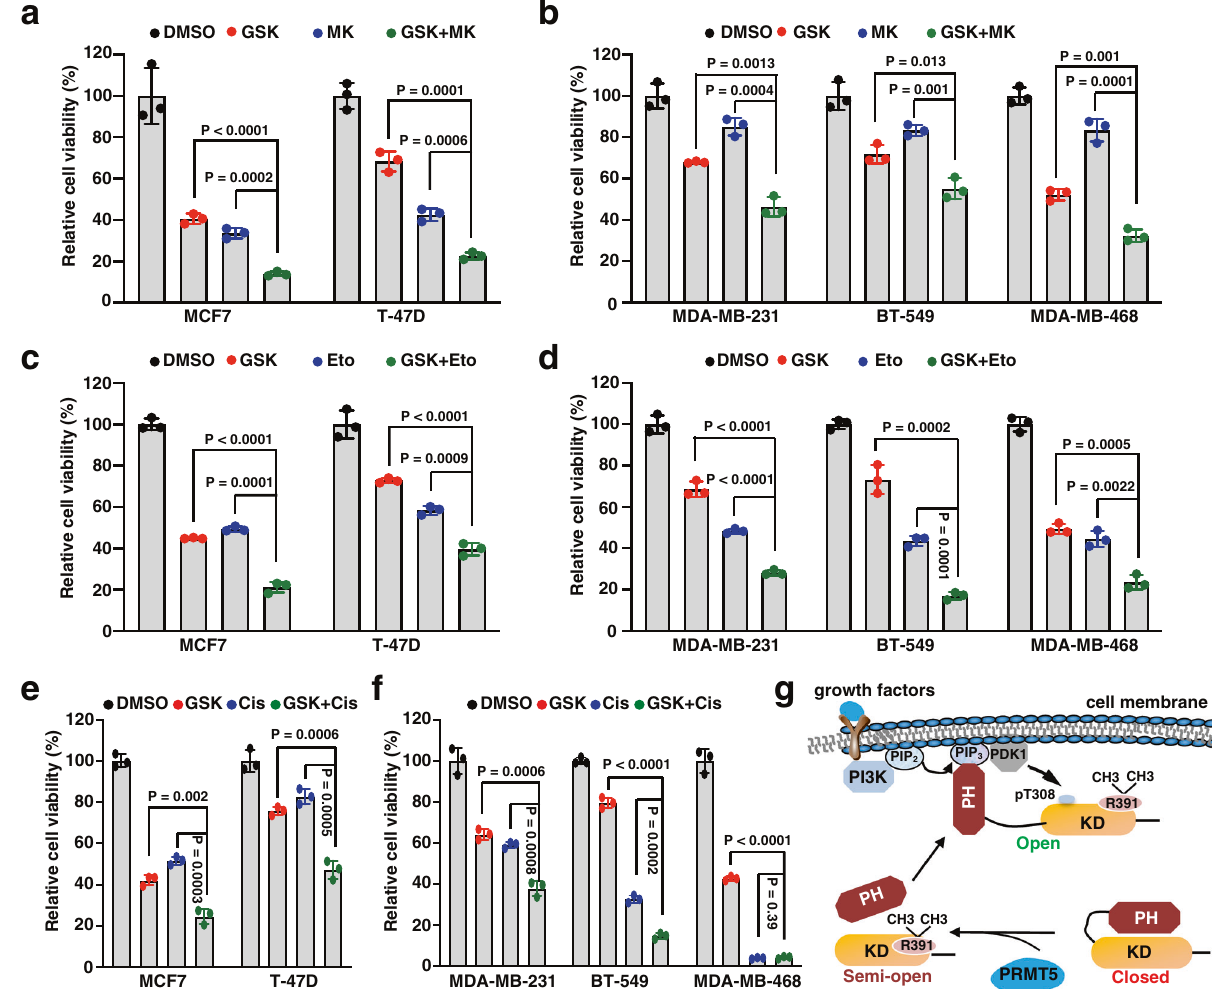
Fig. 7 PRMT5 inhibition sensitizes breast cancer cells to AKT inhibitor and chemotherapeutic agents. a , b Breast cancer cells were treated with DMSO, 0.5 μ M GSK3326595 (GSK), 0.5 μ M MK2206 (MK), or both (GSK + MK) for 4 days before examining cell viability. c , d Breast cancer cells were treated with DMSO, 0.5 μ M GSK, 0.25 μ M etoposide (Eto), or both (GSK + Eto) for 4 days before examining cell viability. e , f Breast cancer cells were treated with DMSO, 0.5 μ M GSK, 2 μ M cisplatin (Cis), or both (GSK + Cis) for 4 days before examining cell viability. g Proposed model to describe the role of AKT1- R391 methylation on promoting PI3K-dependent AKT activation. Statistical signi fi cance was determined by two-tailed Student ’ s t -test in a – f . Statistical source data are provided in Source Data fi